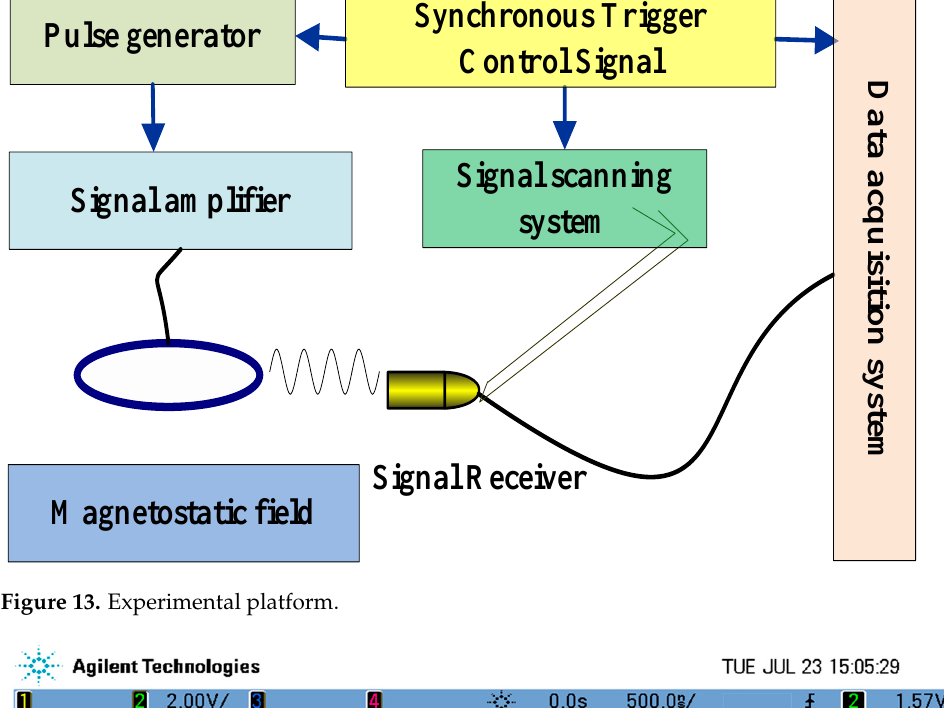
Figure 13. Experimental platform.